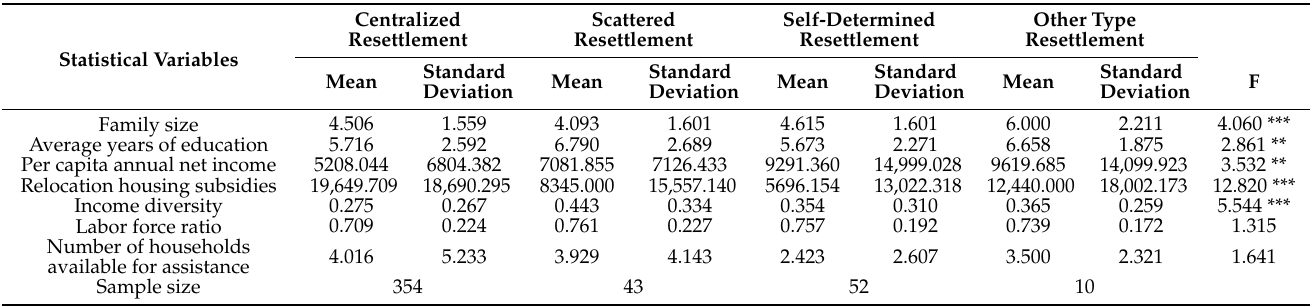
Table 3. Descriptive statistics of the sample.